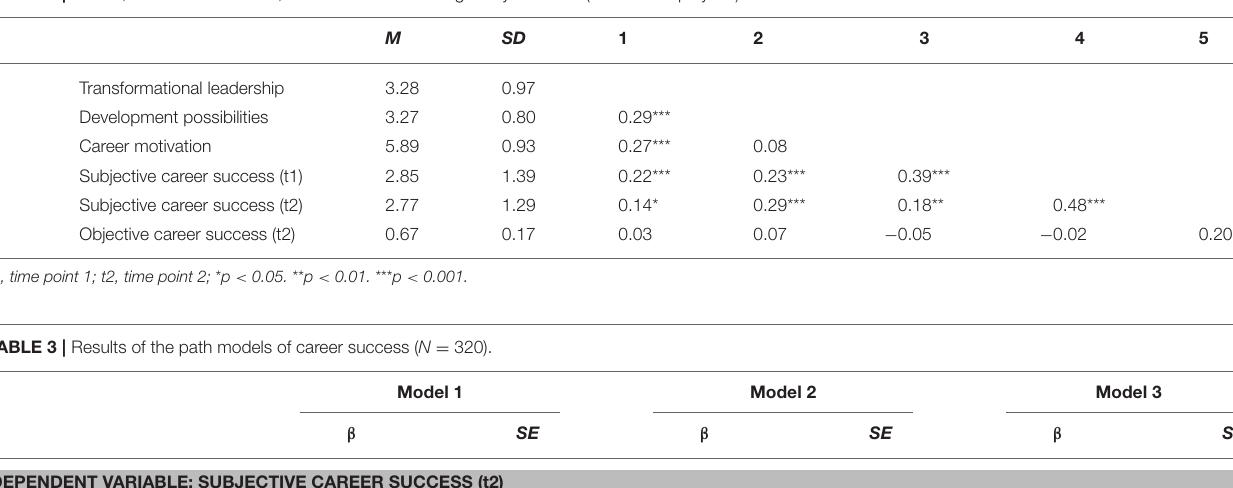
TABLE 2 | Means, standard deviations, and correlations among study variables ( N = 320 employees).